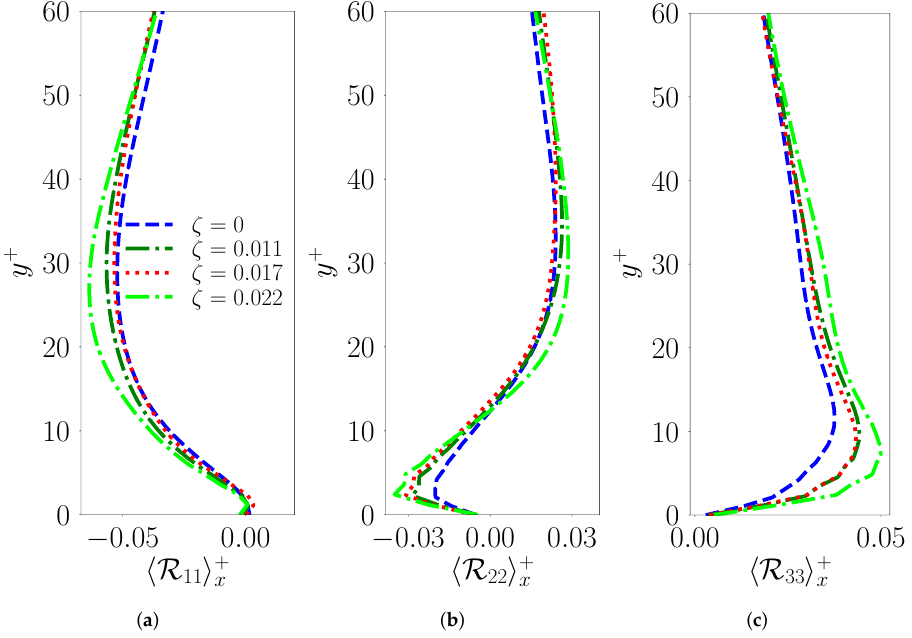
Figure 18. Schematic illustration of the wall-normal variation of the inner–scaled, streamwise-averaged diagonal elements of pressure–rate-of-strain tensor,